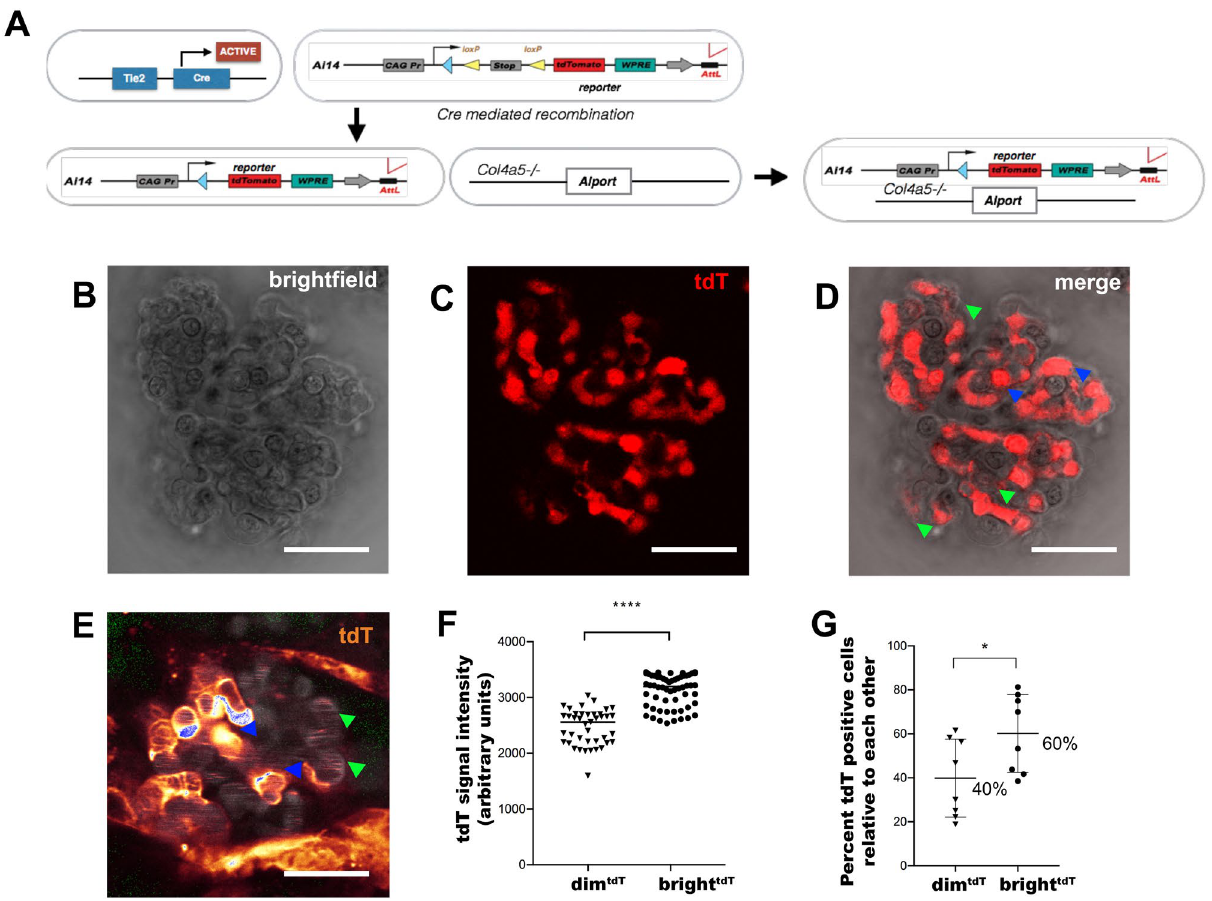
Figure 1. Generation and characterization of GEC specific tdT fluorescence reporter mouse. ( A) Illustration of the breeding schemes used for generating the Tek tdT transgenic reporter mouse in c57BL/6 background in AS mice. ( B–D) Bright-field ( B ) and confocal fluorescence images ( C ) of freshly isolated tdT positive glomeruli. (An overlay image of B and C ( D ), green and blue arrowheads show the dim tdT and bright tdT GEC respectively) ( E, F ) A representative freeze frame image of a tdT positive glomerulus acquired using a Leica SP8 DIVE multiphoton confocal fluorescence imaging system showing the bright tdT (blue arrowheads) and dim tdT GEC (green arrowheads) ( E ), and dot plots showing tdT-signal intensity quantification from these images (measured as pixel density; n = 8 glomeruli) ( F ). ( G) Dot plots showing relative percent composition of the bright tdT and dim tdT cell populations from ( F ). The data are presented as mean ± SD. Scale bars, 50 µm ( B – D ) and 25 µm ( E ). *denotes p value < 0.05; **** denotes p value <